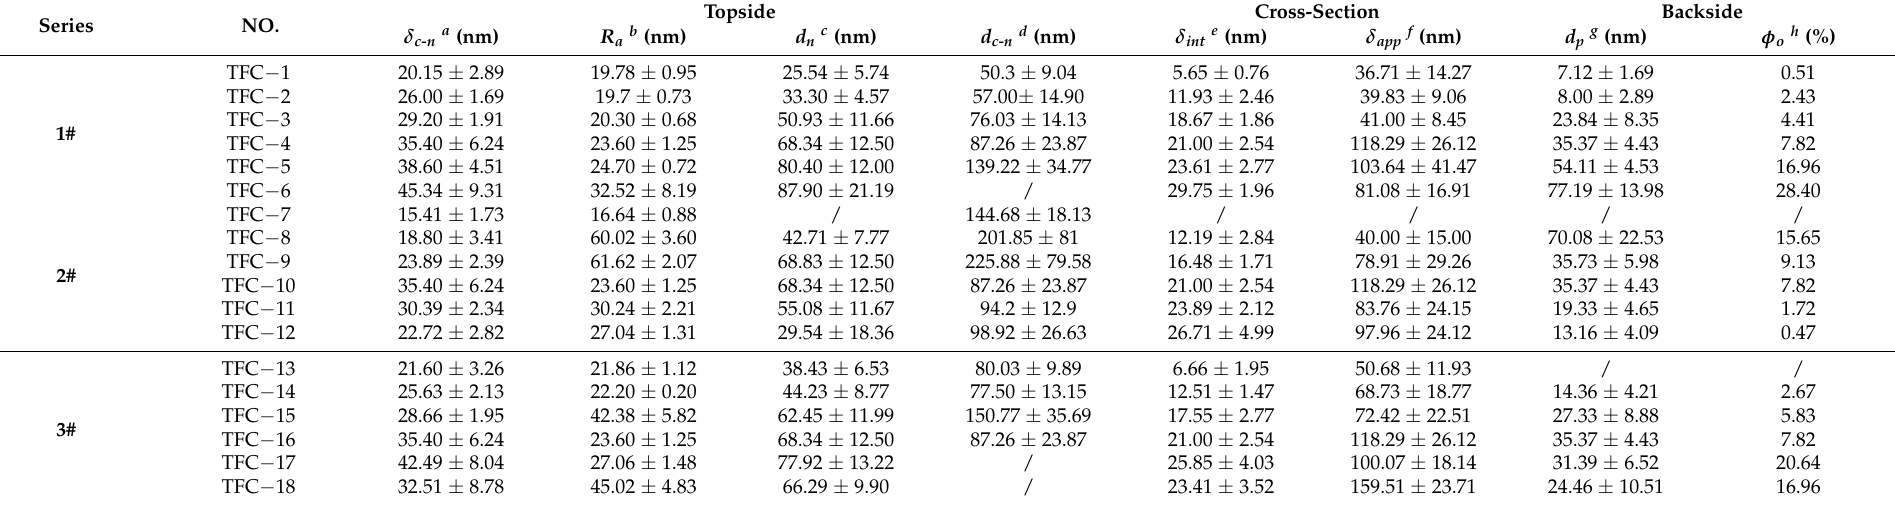
Table 2. The morphological statistics of the features of PA